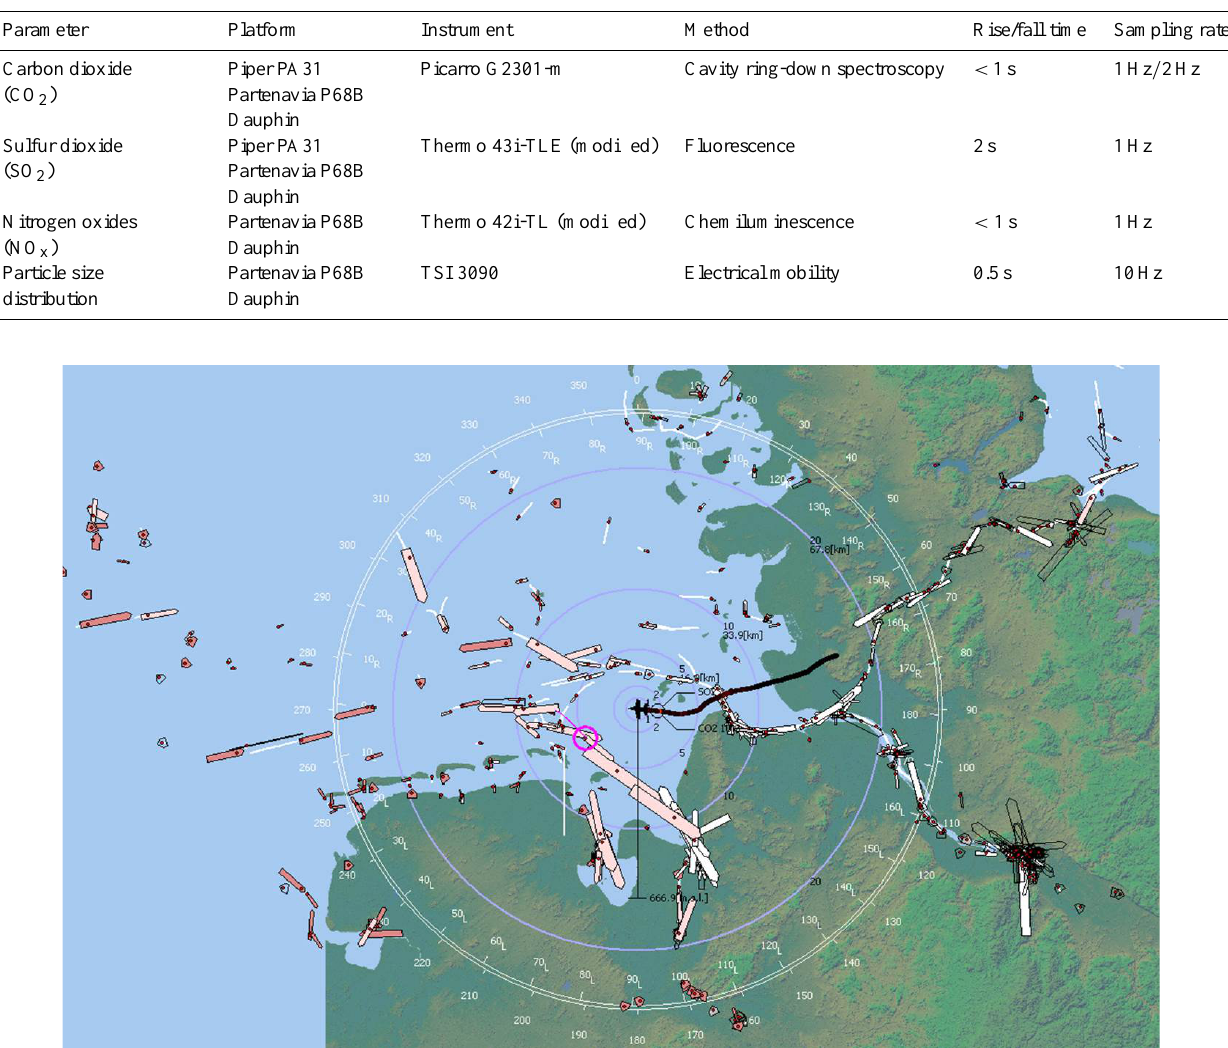
Figure 4. Map for real-time navigation purpose presented to the operator by IGPS software showing the current locations of surrounding ships and aircraft from the received Automatic Identification System (AIS) data sent by the ships. The different size of the ships corresponds to their gross tonnage. The blue circles around the aircraft’s location indicate the distance to the ships and the time required to reach these. The two white circles provide information about ship locations relative to aircraft with respect to north and the current course of the aircraft.